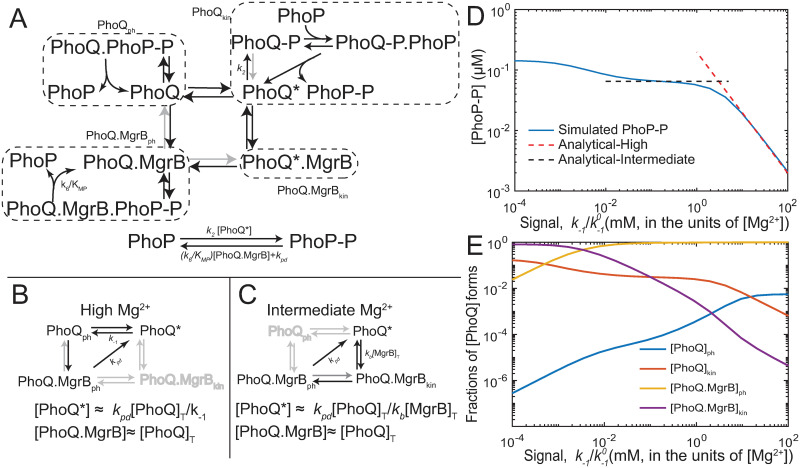
Understanding the biphasic dose-response possible in the two-state model of PhoPQ.A—Reactions in PhoPQ-MgrB network. Dotted squares enclose 4 sub forms of PhoQ (Qph, Qkin, QBph, QBkin). 4 reactions outside the dotted squares have rates comparable to dilution due to growth. Each sub form dilutes with a rate kpd, while synthesis is only in the Q* form. B—Most significant fluxes at high Mg2+. Steady state [PhoP-P] is approximated by matching phosphorylation and dephosphorylation fluxes. Phosphorylation flux is proportional to 1/k−1, while dephosphorylation flux is approximately constant. C- Most significant fluxes at intermediate Mg2+. Phosphorylation flux is proportional to [B]Total and independent of k−1 while dephosphorylation flux is still approximately constant D- [PhoP-P] as a function of signal showing plateau at intermediate Mg2+. Blue line indicates simulated [PhoP-P] from the model in the previous section. Red dashed line shows approximate [PhoP-P] in the high Mg2+ range, and black dashed line shows the approximate plateau value of [PhoP-P] in the intermediate Mg2+ range. E- Fractions of total Q in the 4 catalytic forms.